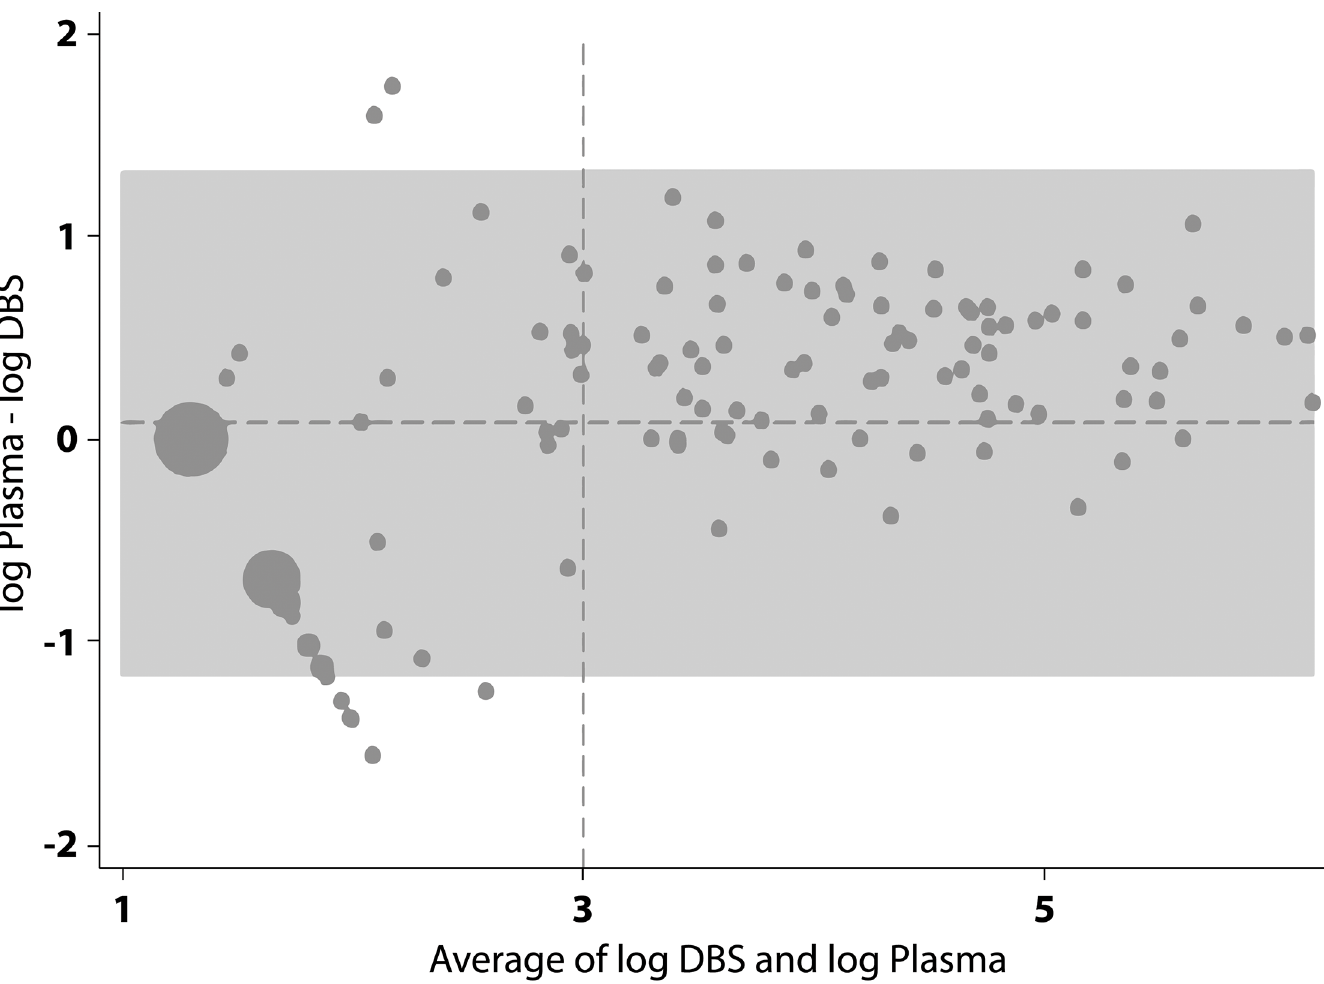
Fig 2. Bland-Altman plot of the agreement between DBS versus plasma viral load. The horizontal dotted line represents the mean difference of 0.077 log 10 . The grey area represents ± 1.96 standard deviations. The vertical dotted line represents the 3 log 10 cut-off for detectable viral load.